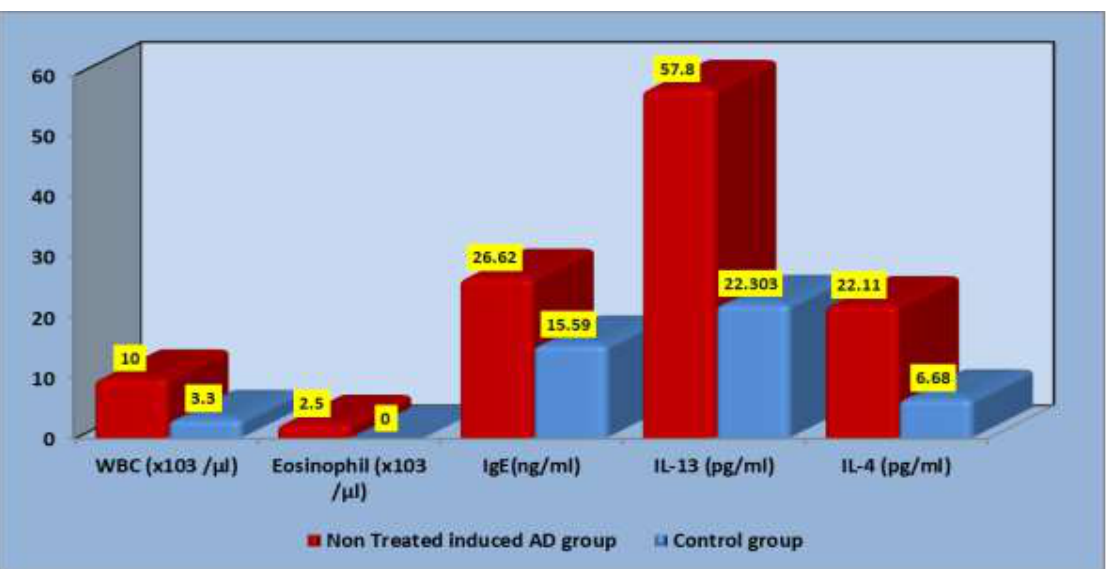
Figure 2. Comparison between means of controls and non-treated atopic dermatitis induced group regarding WBC, Eosinophil, serum IgE, skin tissue homogenate of IL-13 and IL-4.; AD: atopic dermatitis. WBC: white blood cells, IgE: immunoglobulin E, IL-13: interleukin 13, IL-4: interleukin 4. Results are expressed as mean ± SD, P is significant at ≤